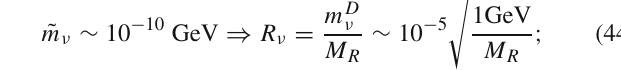
carried by the scalar. If heavy neutrino and new charged lep- and m M (cid:4) ), are about hundreds GeV, then ton masses, ( m χ M L the ratio m k / m μ ∼ 100 GeV / 100 MeV ∼ 10 3 , which indi- cates the dominated factor of the second term over the first